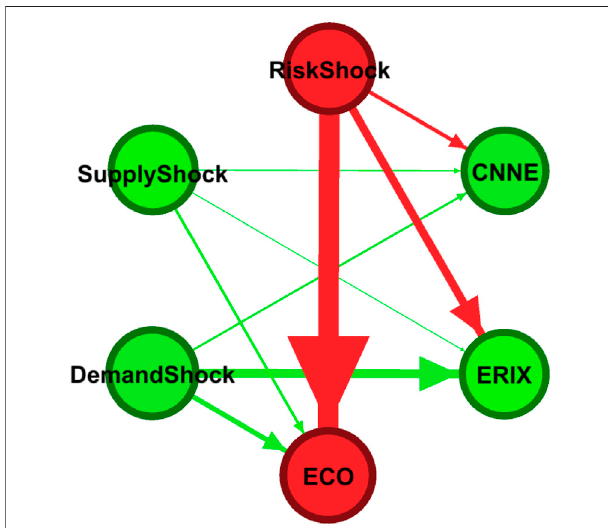
FIGURE 1 | Directional net connectedness network of oil shocks and new energy returns.